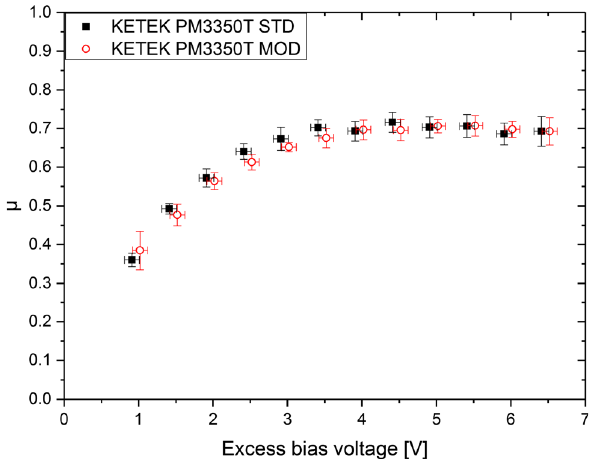
Fig. 5 Average number of detected photons per light pulse μ